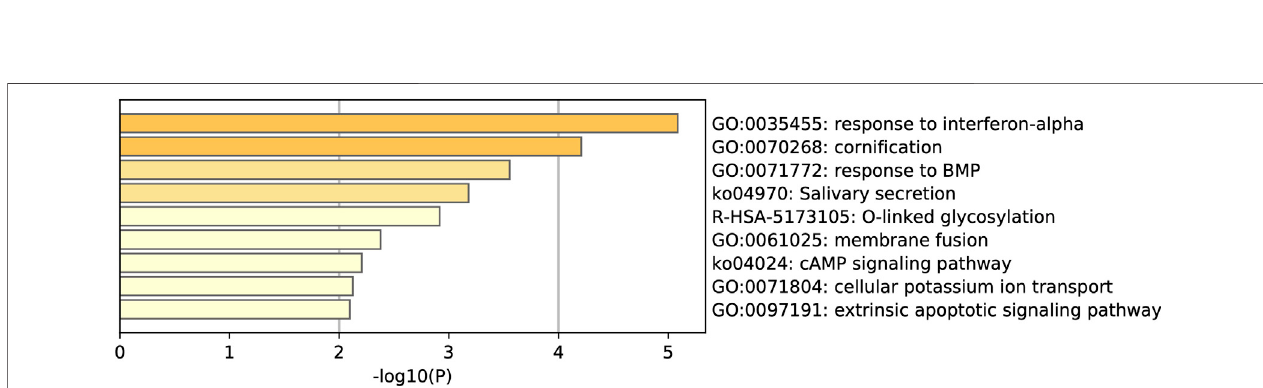
FIGURE11|(A) FromtheCOVID-19DEGs,58genesarecommonbetweennasopharyngealswabsandwholebloodsamples (B) fi vegenesarecommonfromthe COVID-19 speci fi c DEGs.